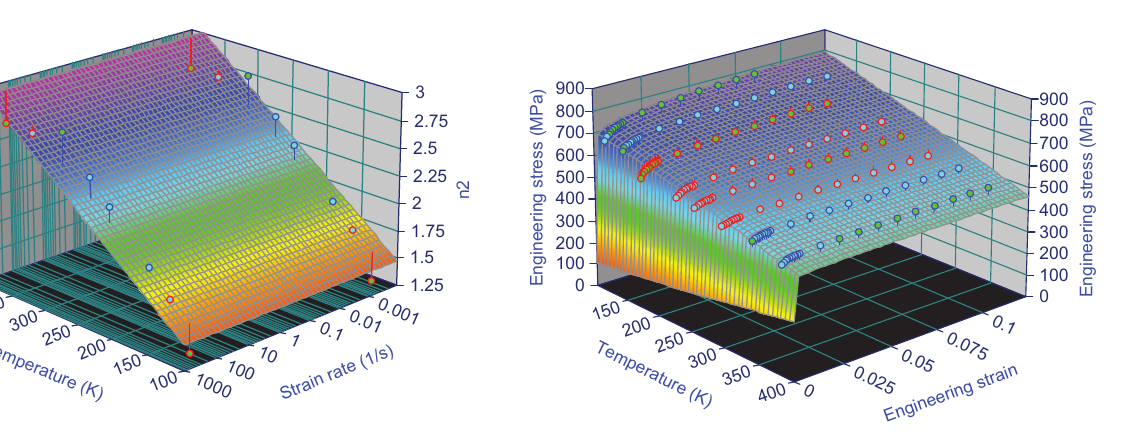
Figure 6 Change of softening exponent n vs. temperature and 2 strain rate. Figure 7 Stress-strain diagram for a wide range of temperatures at a shear strain rate of 5 × 10 -4 /s.